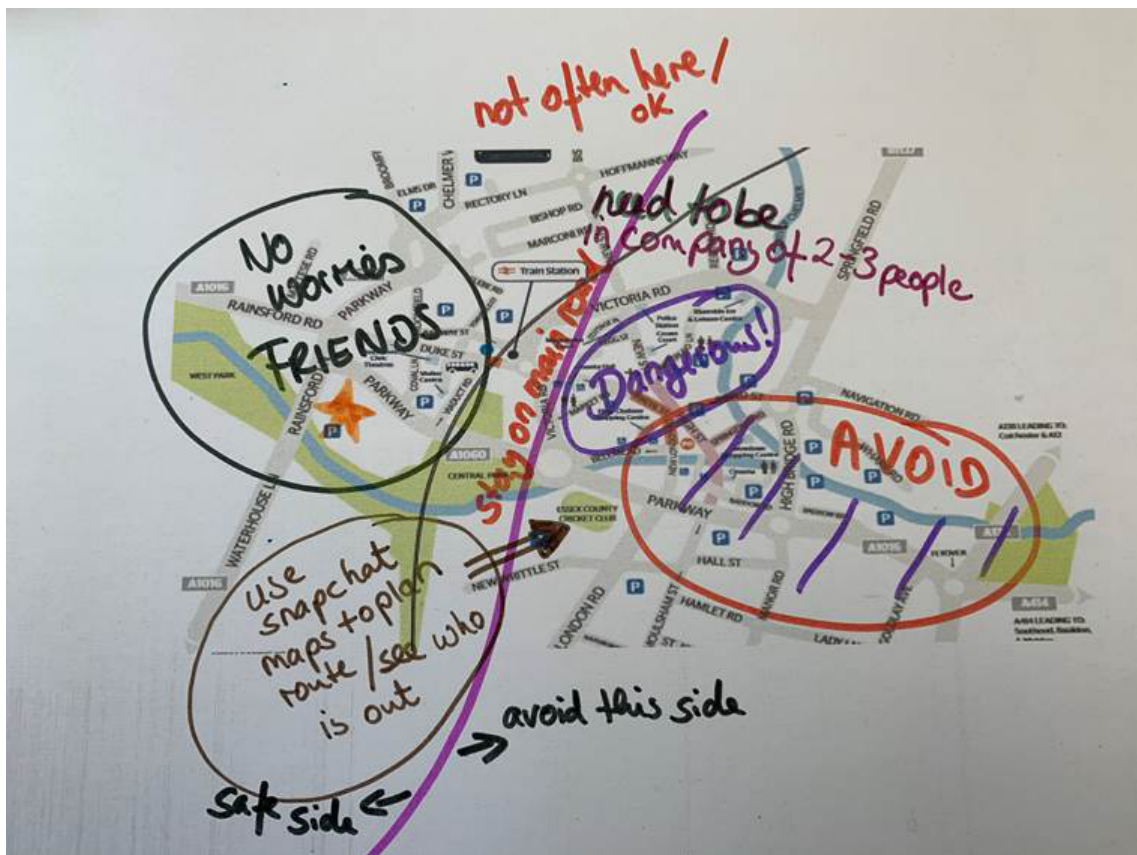
Figure 1. Example map created to preserve the young person’s anonymity – his real map included much more information, drawings and figures [Copyright 2020, Bianka